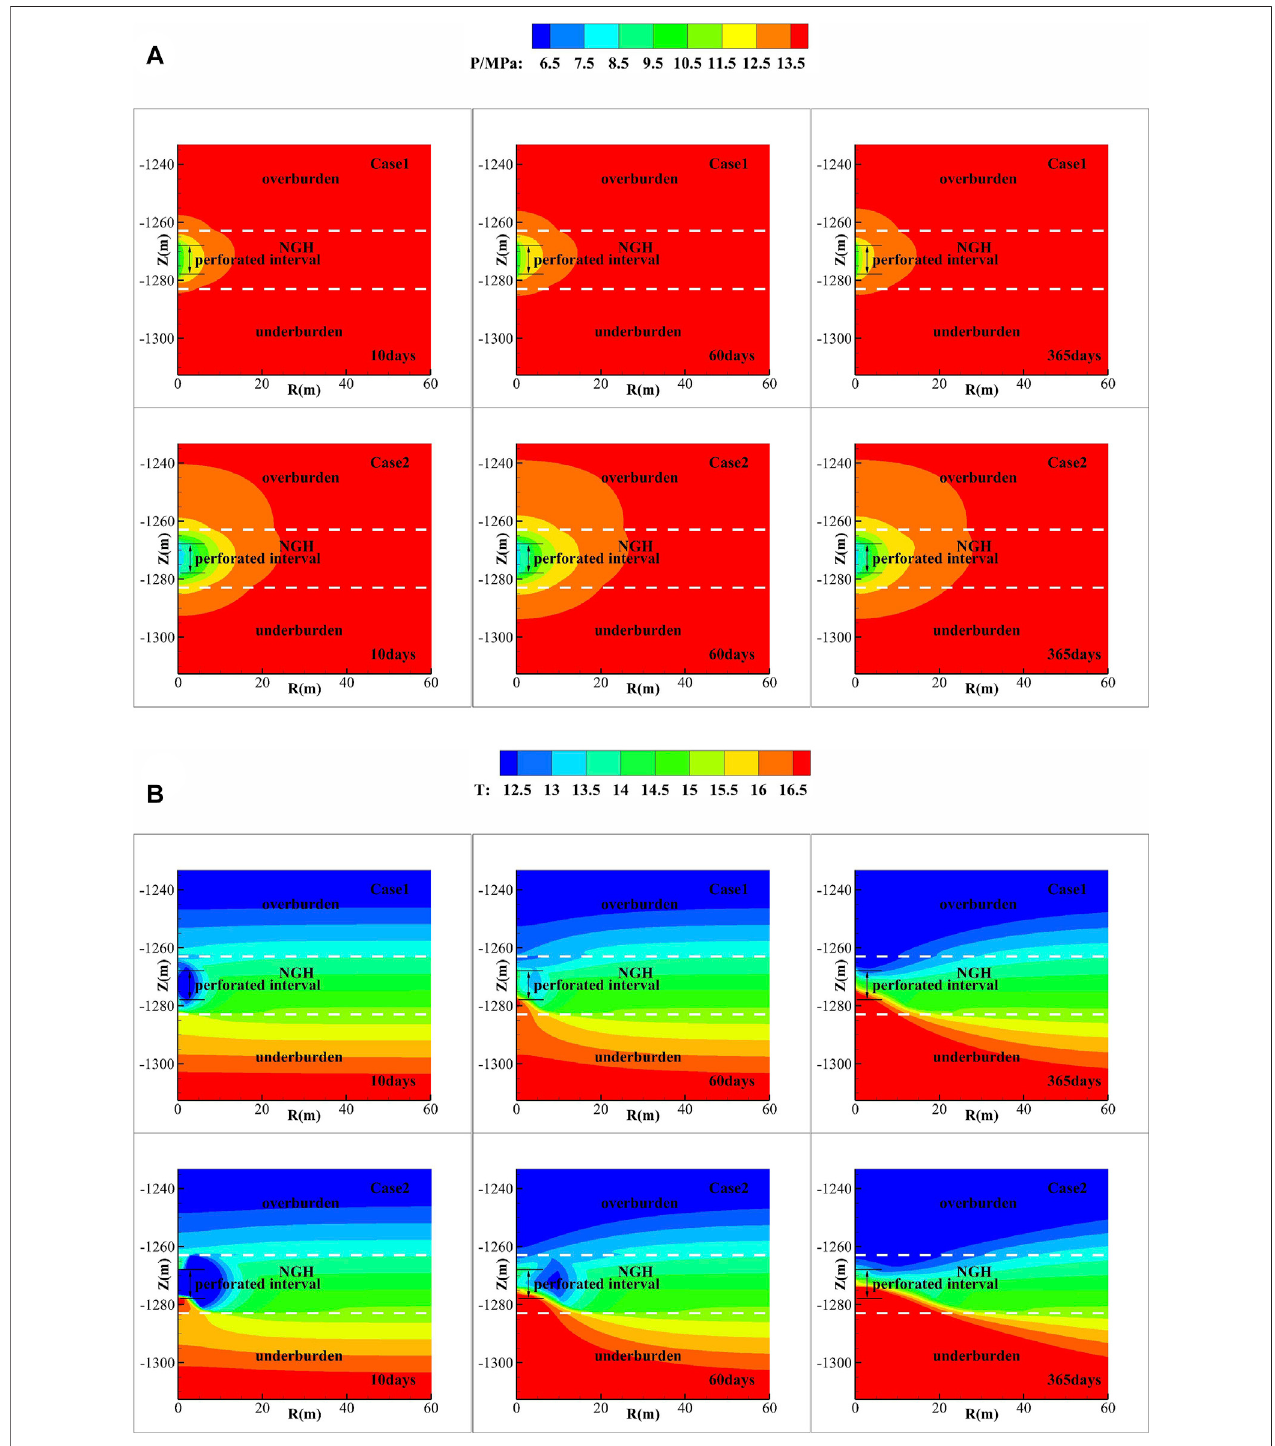
FIGURE7| SpatialdistributionofpressureMPa (A) ,temperature ° C (B) ,hydratesaturation (C) ,andgassaturation (D) after10,60,and365 daysafterandbeforereservoirstimulation.